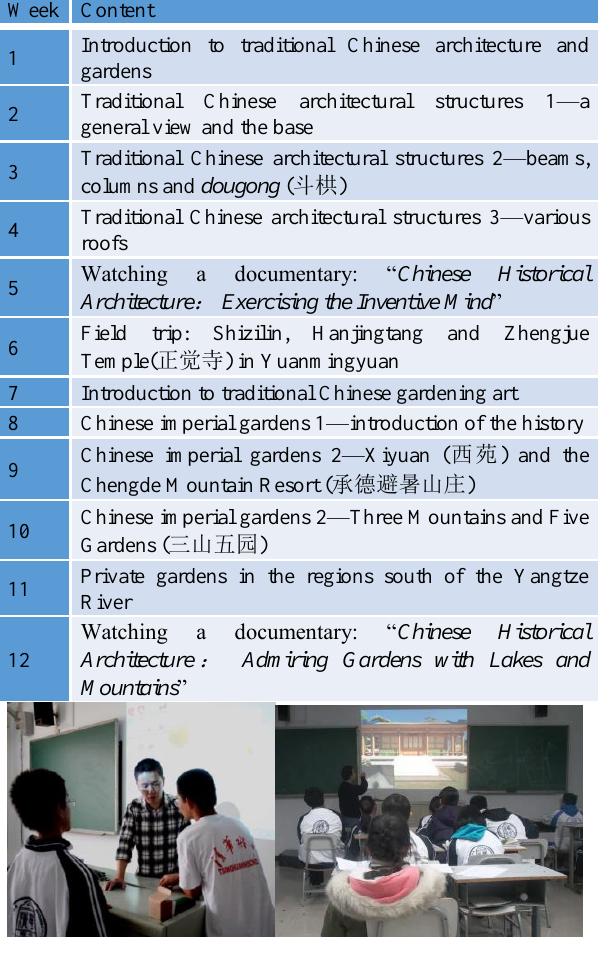
Figure 3. Students having class “ Traditional Chinese Architecture and Gardens”